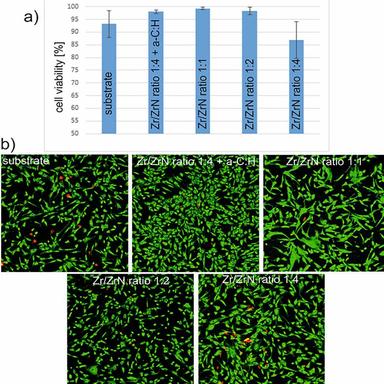
Analysis of cytotoxicity of the corrosive fluids following corrosion testing; a). a diagram of the cell viability in relation to the type of corrosive fluid following corrosion testing; and b) images of cells acquired by confocal microscopy.